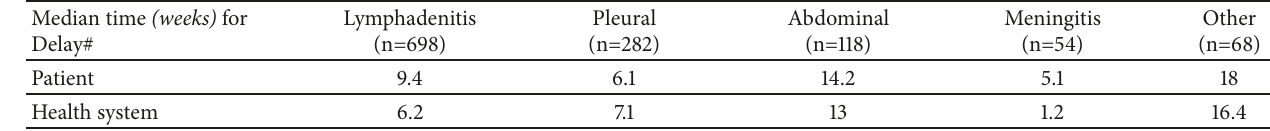
Table 4: Patient and health system delays in various forms of extrapulmonary tuberculosis (N=1220). Median time (weeks)